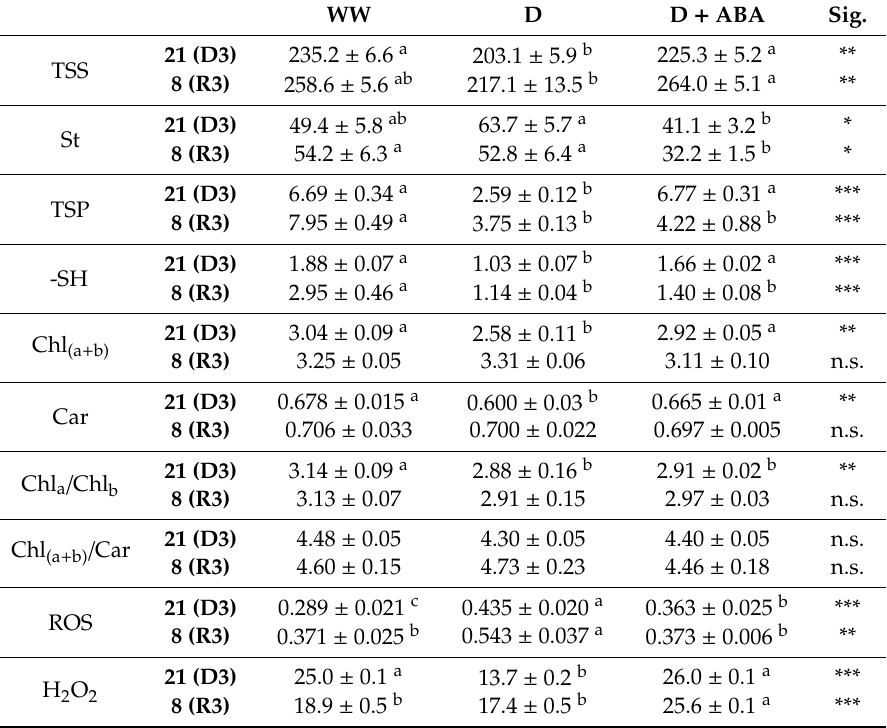
Table 1. Oxidative stress indicators and foliar metabolites concentrations of well-watered (WW) and droughted without (D) and with abscisic acid (D + ABA) plants during the 3rd drought (D3) and recovery (R3) periods. Total soluble sugars (TSS, mg g − 1 DW), starch (St, mg g − 1 DW), total soluble proteins (TSP, mg g − 1 DW), total thiols (-SH, nmol mg − 1 DW ), total chlorophylls (Chl (a + b), mg g − 1 DW) and total carotenoids (Car, mg g − 1 DW), and the ratio of chlorophyll a / chlorophyll b (Chl a / Chl b ) and chlorophylls / carotenoids (Chl (a + b) / Car), total reactive oxygen species (ROS, nmol g − 1 DW) and H 2 O 2 ( µ mol g − 1